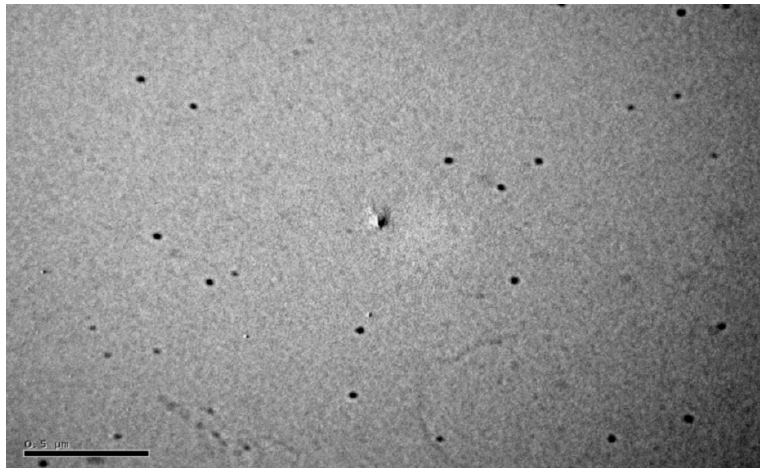
Figure 5. Transmission electron micrograph of niosomes formed after hydration of F4 formula.